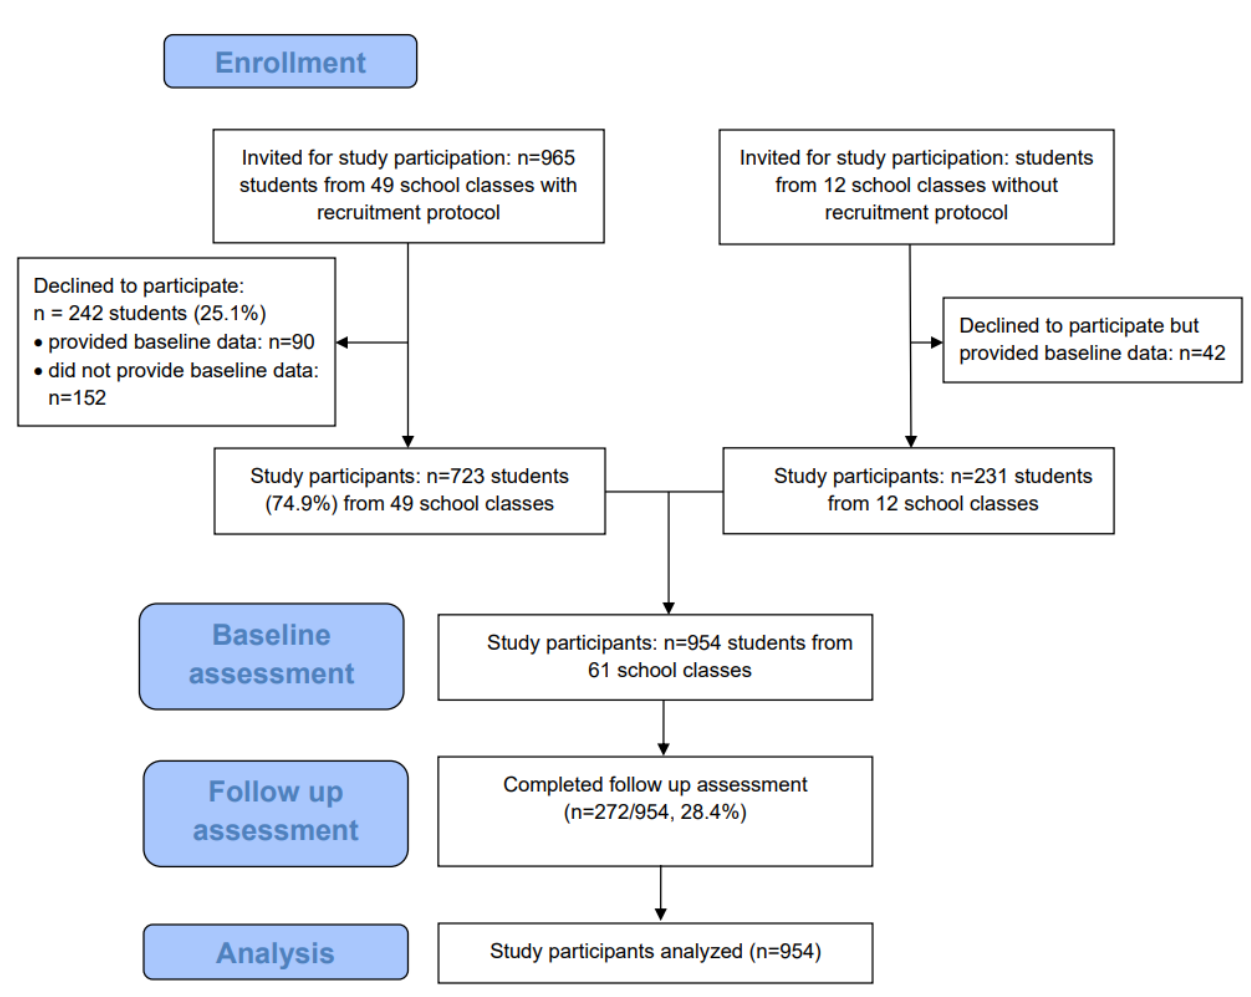
Figure 3. Flow chart of the study participants.